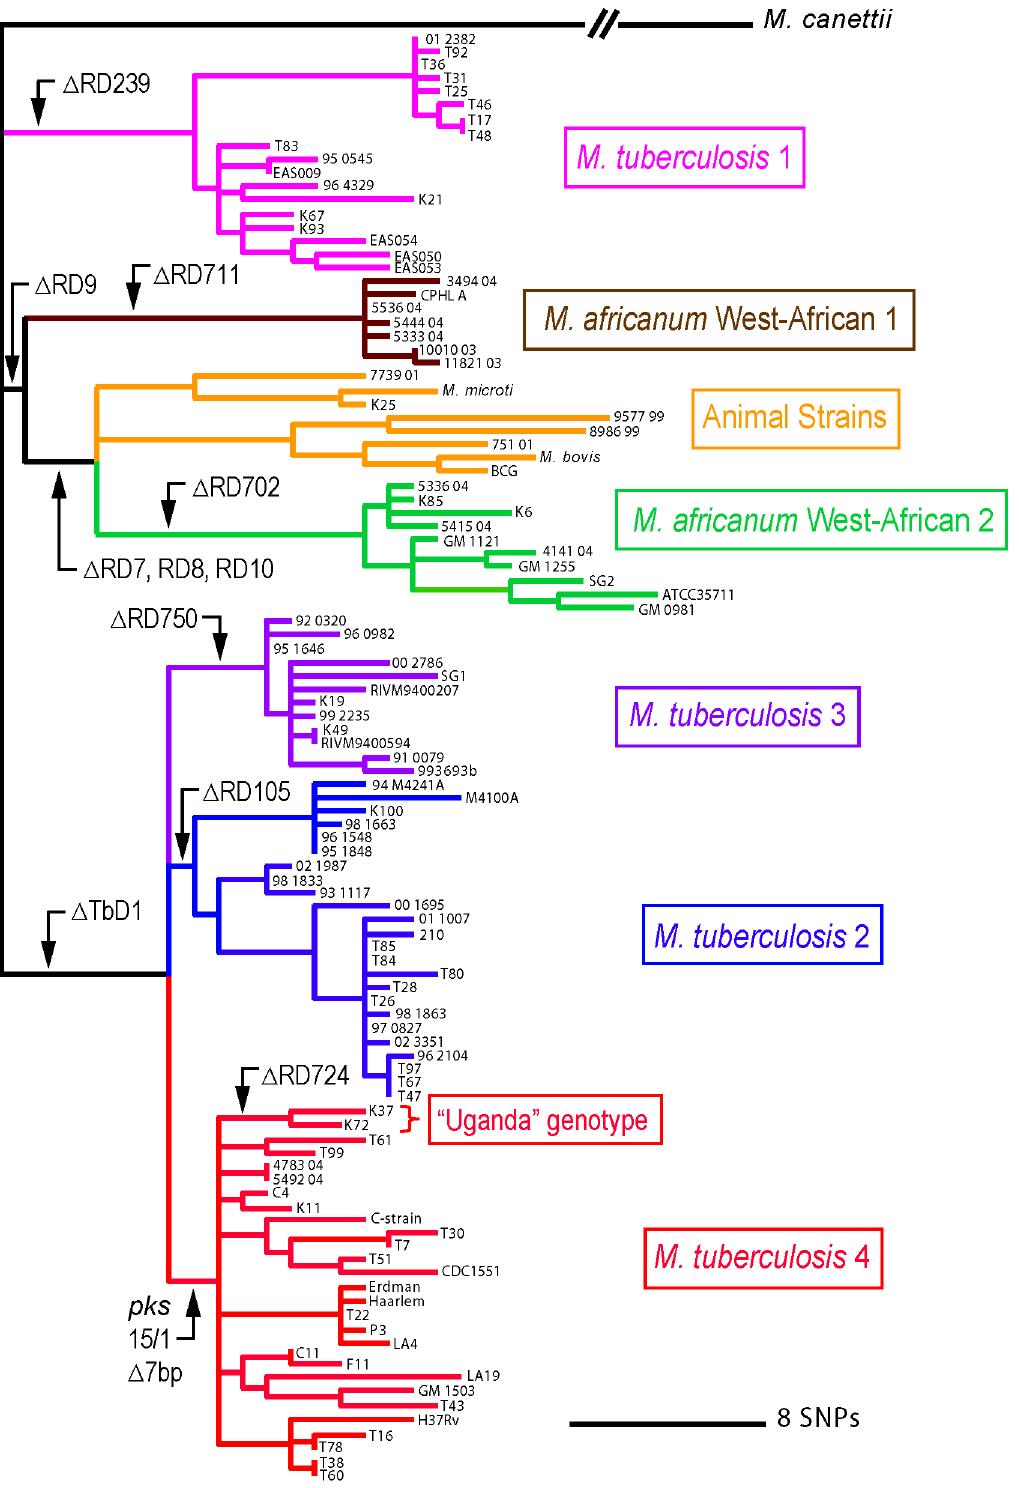
Figure 2. The position of M.africanum in the global phylogeny of the M.tuberculosis complex (MTBC) as originally published by Hershberg et al. [ 23 ] . This phylogeny is based on over 65 kb of DNA sequence data (89 concatenated gene sequences) in each of 108 strains of the MTBC and was inferred using maximum parsimony, which resulted in a single tree with negligable homoplasy [23]. Analysis by the neighbor-joining method resulted in an identical tree topology with high statistical support for all main branches [23]. This phylogeny has been referred to as the most robust and most detailed phylogeny of the MTBC to date, and thus should be considered as the new gold standard for classification of the MTBC [87]. The six main MTBC lineages adapted to humans and the animal strains are indicated in different colors. The human MTBC lineages include four M. tuberculosis lineages and the two M. africanum type I lineages. The ‘‘Uganda’’ genotype (formally referred to as M. africanum type II), which is a sub- lineage within M. tuberculosis lineage 4 (also known as the Euro-American lineage), is also shown. These lineages are completely congruent to